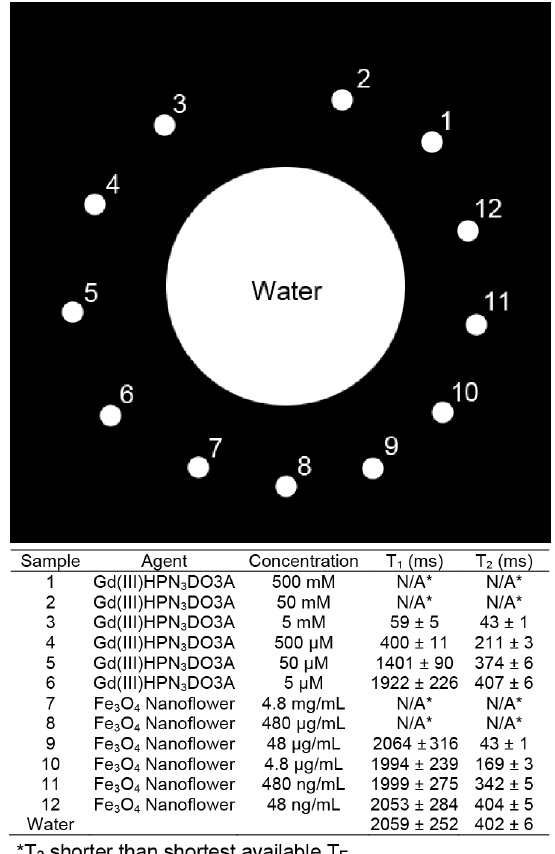
Figure 3. Legends and characterizations of solution phantom samples